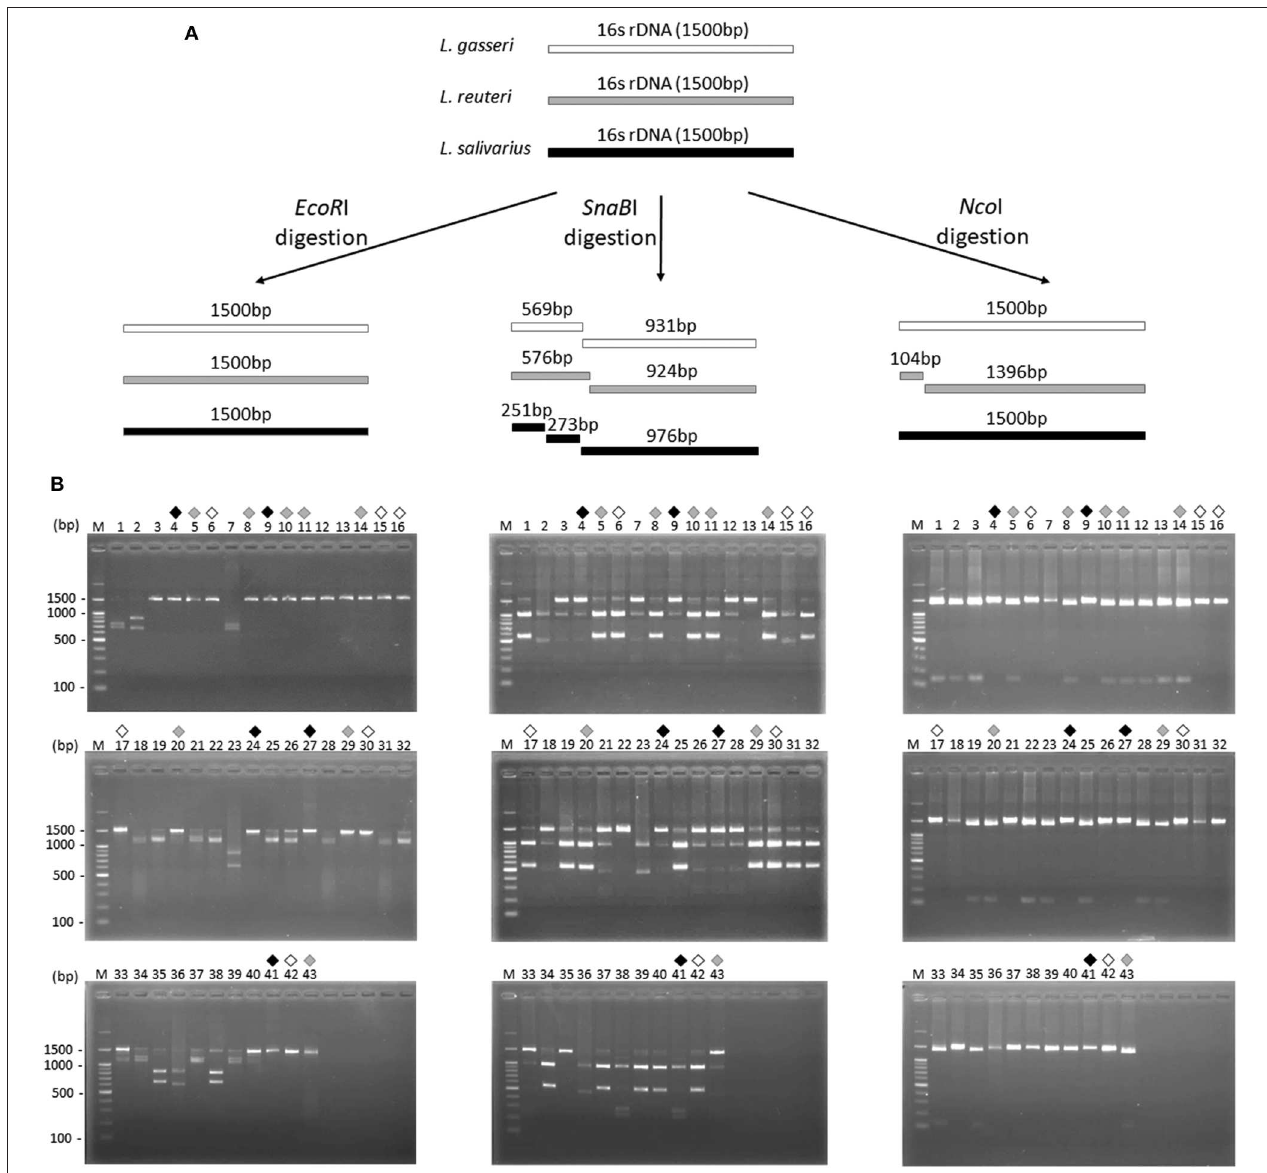
FIGURE 2 | Restriction fragment length polymorphism analysis of 16S ribosomal DNA of three Lactobacillus species. (A) Illustration of the 16S rDNA fingerprint patterns of L. gasseri (white bar), L. reuteri (gray bar), and L. salivarius (dark gray bar) after Eco RI, Sna BI, and Nco I digestion, respectively. (B) The 16S rDNA fingerprint patterns digested with EcoR I (left panel), Sna BI (middle panel), and Nco I (right panel) of 43 colonies isolated from MRS agar plates. Suspected colonies of L. gasseri (black open diamond), L. reuteri (gray diamond), and L. salivarius (black diamond) were